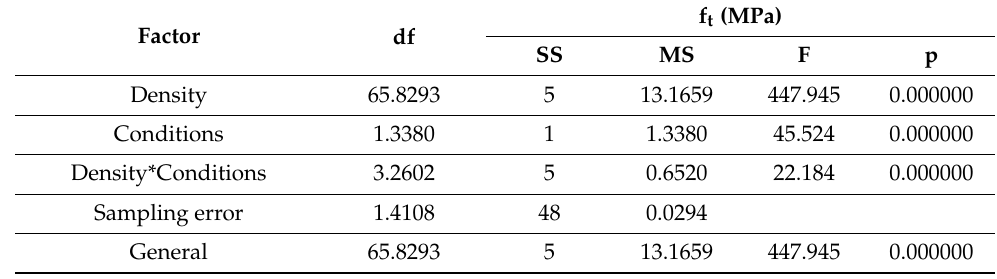
Table 3. Variance analysis for the tensile strength (f t ): SS—sum of squares, MS—mean squares,